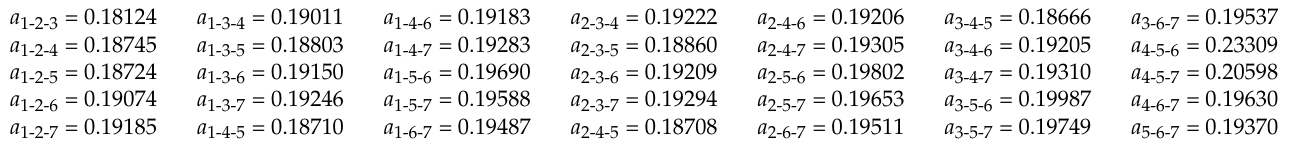
Table 3. The set of a r - s - t values of the probable theoretical elastic deformation of the PAI 25 press frame, determined based on k = 7 FEA analyses with different discretization levels (in